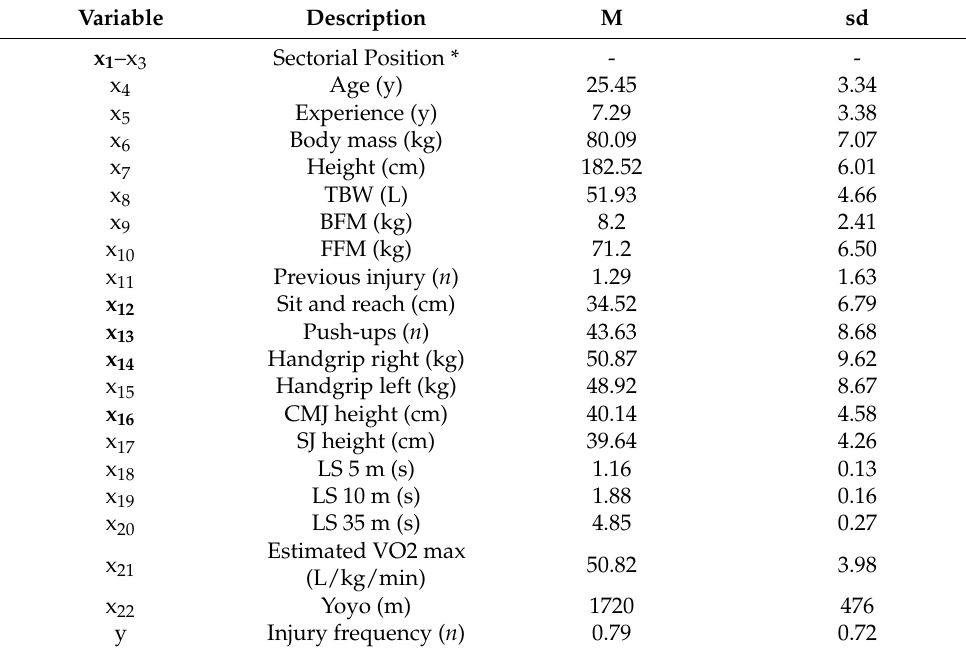
Table 1. Description of the variables used to construct the predictive model (N =